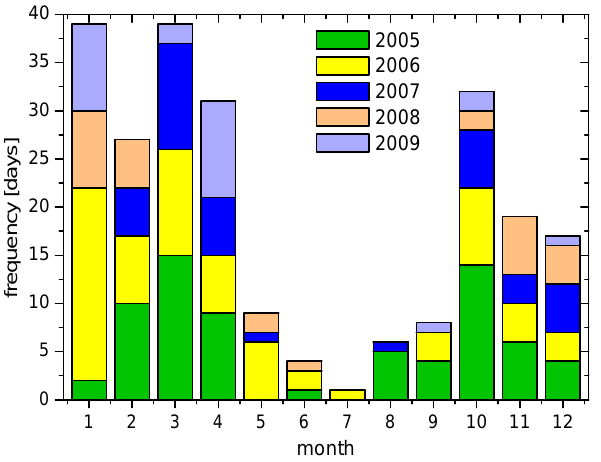
Fig. 5. Exceedances of the daily PM 10 limit value at the roadside site Leipzig-Mitte keyed after month of the year. Data coverage: 2005-2009.